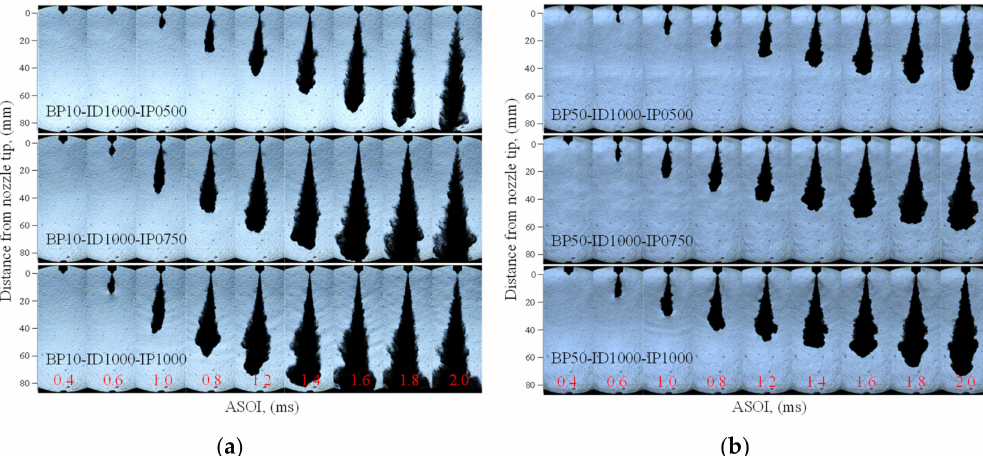
Figure 5. Spray development patterns of gasoline-biodiesel (GB)05 with back pressure at ( a ) 10 bar, and ( b ) 50 bar, undergoing an injection duration of 1000 µ s at three states of the injection pressure of 500, 750 and 1000